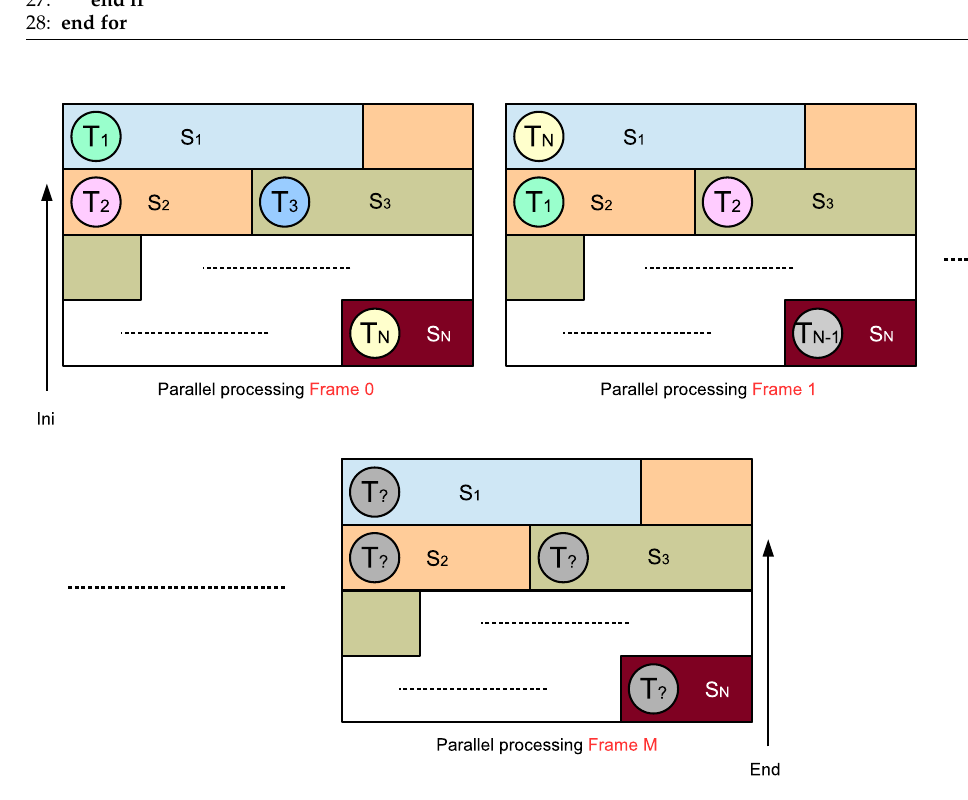
Figure 9. JEM-SP-ASync: Graphical scheme of the slice-based asynchronous parallel